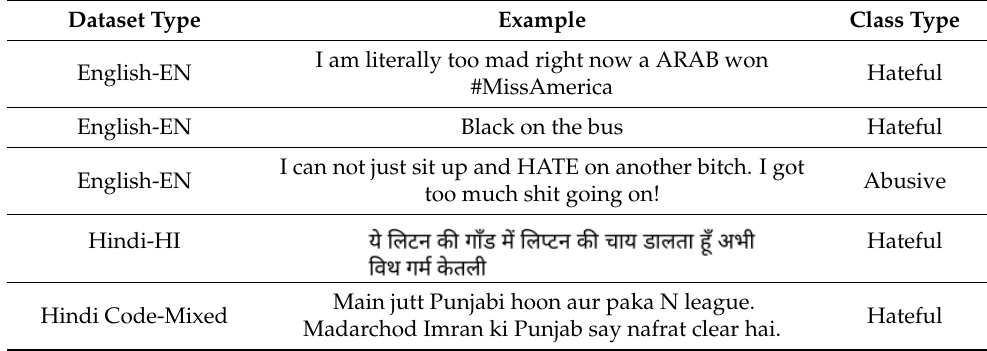
Table 3. Example